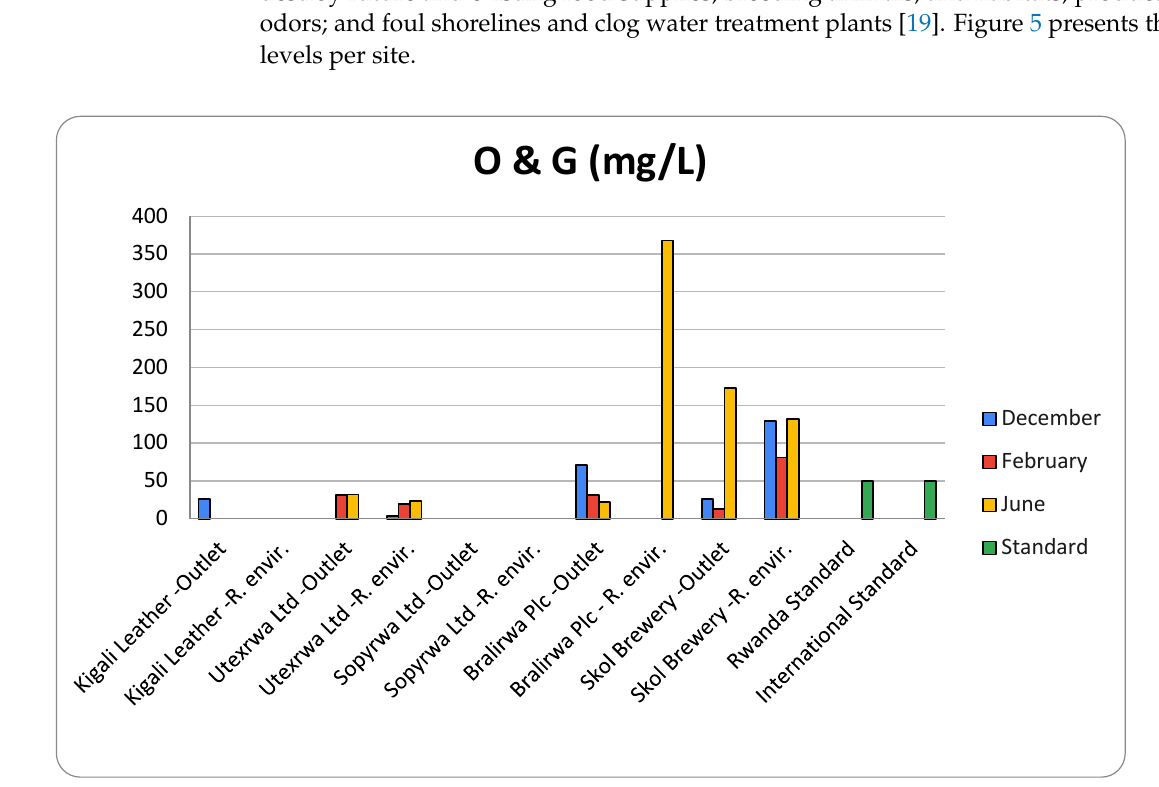
Figure 5. Oil and grease levels per site .